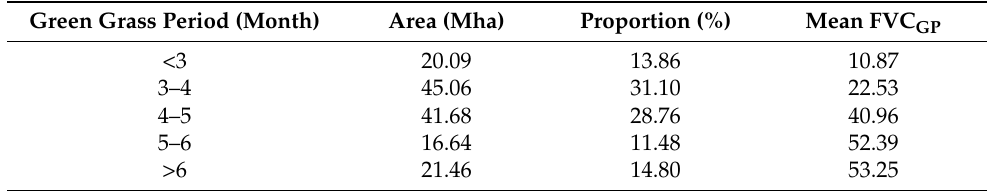
Table 2. Area, proportion, and mean Fractional Vegetation Cover in the green grass period (FVC GP ) of grasslands with different green grass period (GP) in the TP during 2000–2019. Green Grass Period (Month) Area (Mha) Proportion (%) Mean FVC GP <3